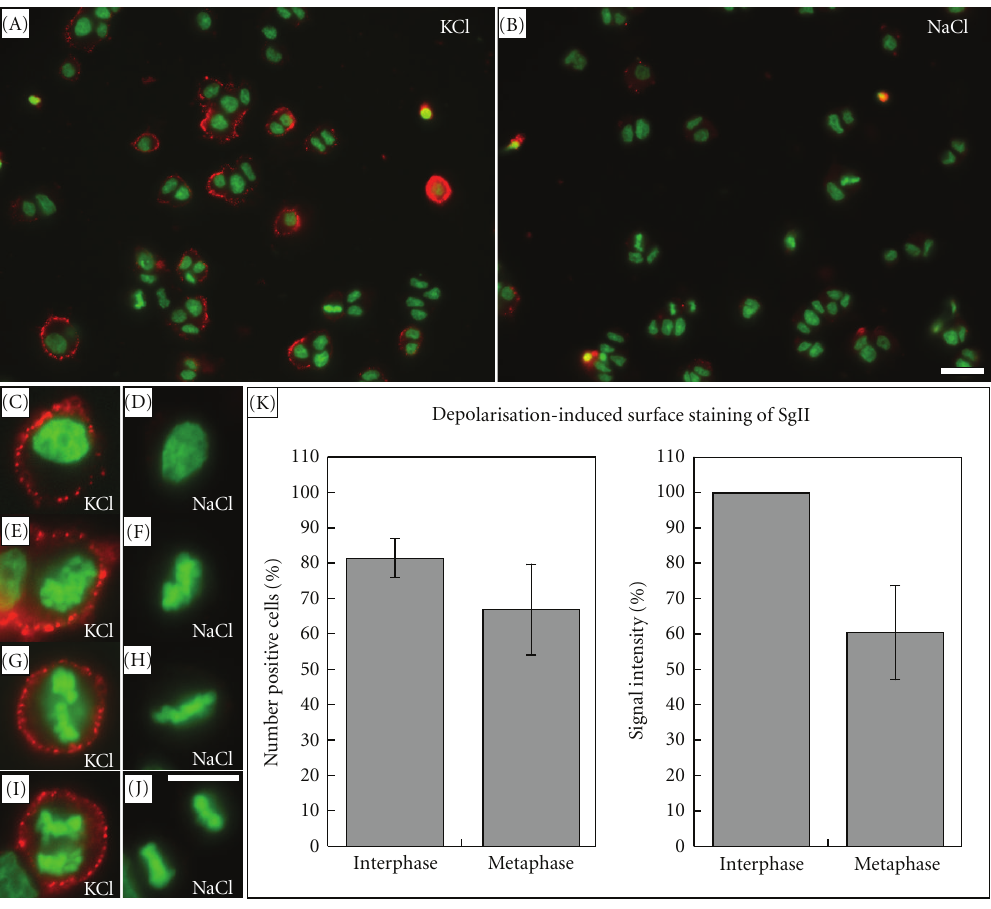
Figure 9: Analysis of regulated exocytosis in mitotic PC12 cells. Synchronized PC12 cell populations were incubated in growth medium supplemented with either 55mM KCl ((A), (C), (E), (G), (I)) or 55mM NaCl ((B), (D), (F), (H), (J)) and processed for immunofluorescence staining of surface-associated SgII (red) and DNA-staining (green). Interphase cells ((C) and (D)) and dividing cells at di ff erent stages of mitosis displayed prominent SgII surface staining under stimulating conditions ((E), prophase, (G), metaphase, (I), anaphase) but not under control conditions ((F), prophase, (H), metaphase, (J), anaphase). Scale bars: images (A) and (B), 10 μ m, (C) to (J), 5 μ m. (K) Quantitative analysis of the signal intensity of the SgII surface staining revealed that 81 ± 11% ( ± SD) of the interphase and 67 ± 26% ( ± SD) of the metaphase cells displayed a signal intensity above the background value determined under control conditions. In addition, the signal intensity of the SgII surface staining of metaphase cells was on average 61 ± 13% ( ± SD) of the mean intensity of interphase cells. For the evaluation, interphase and metaphase cells ( n > 80, resp.) were randomly chosen from two independent